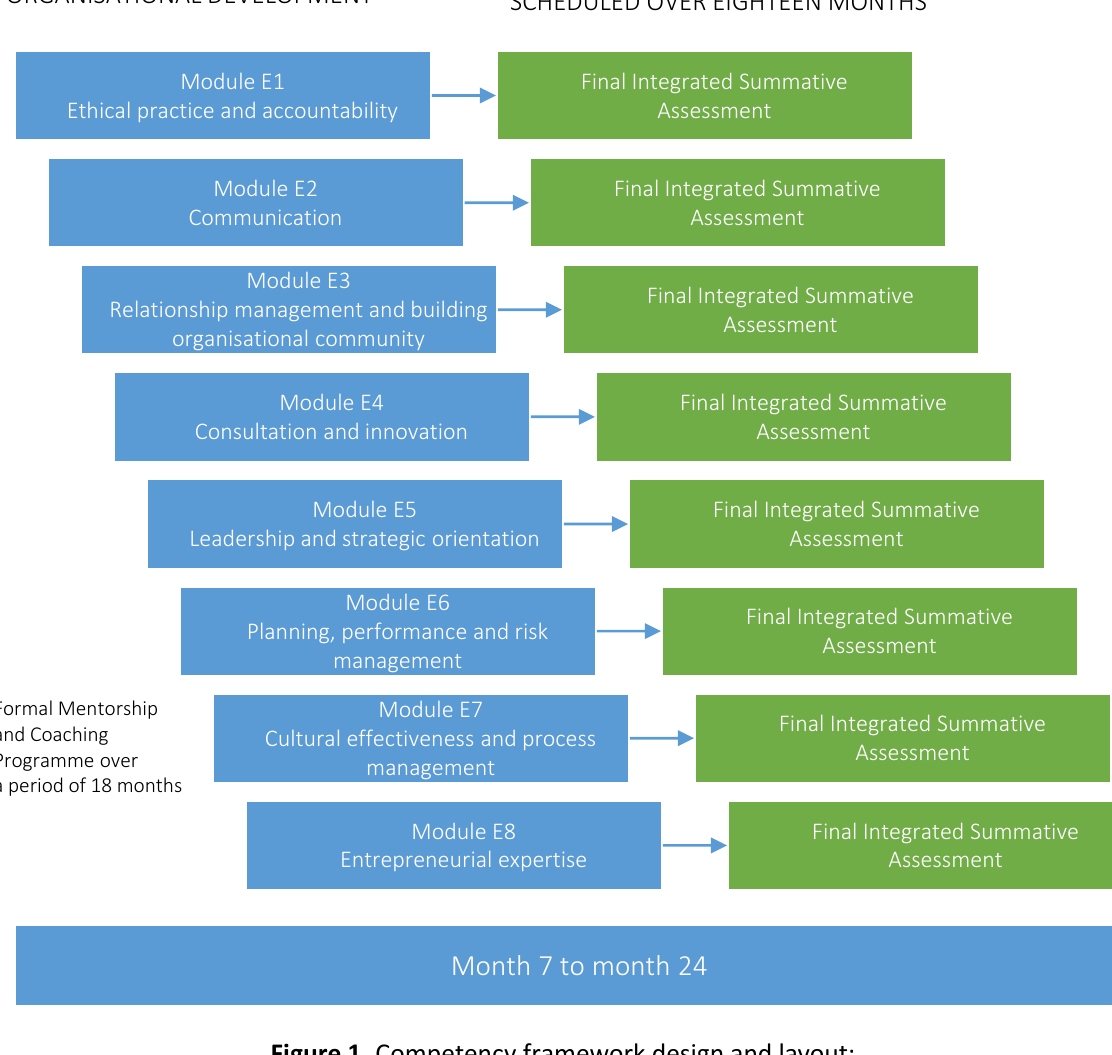
Figure 1. Competency framework design and layout: women empowerment